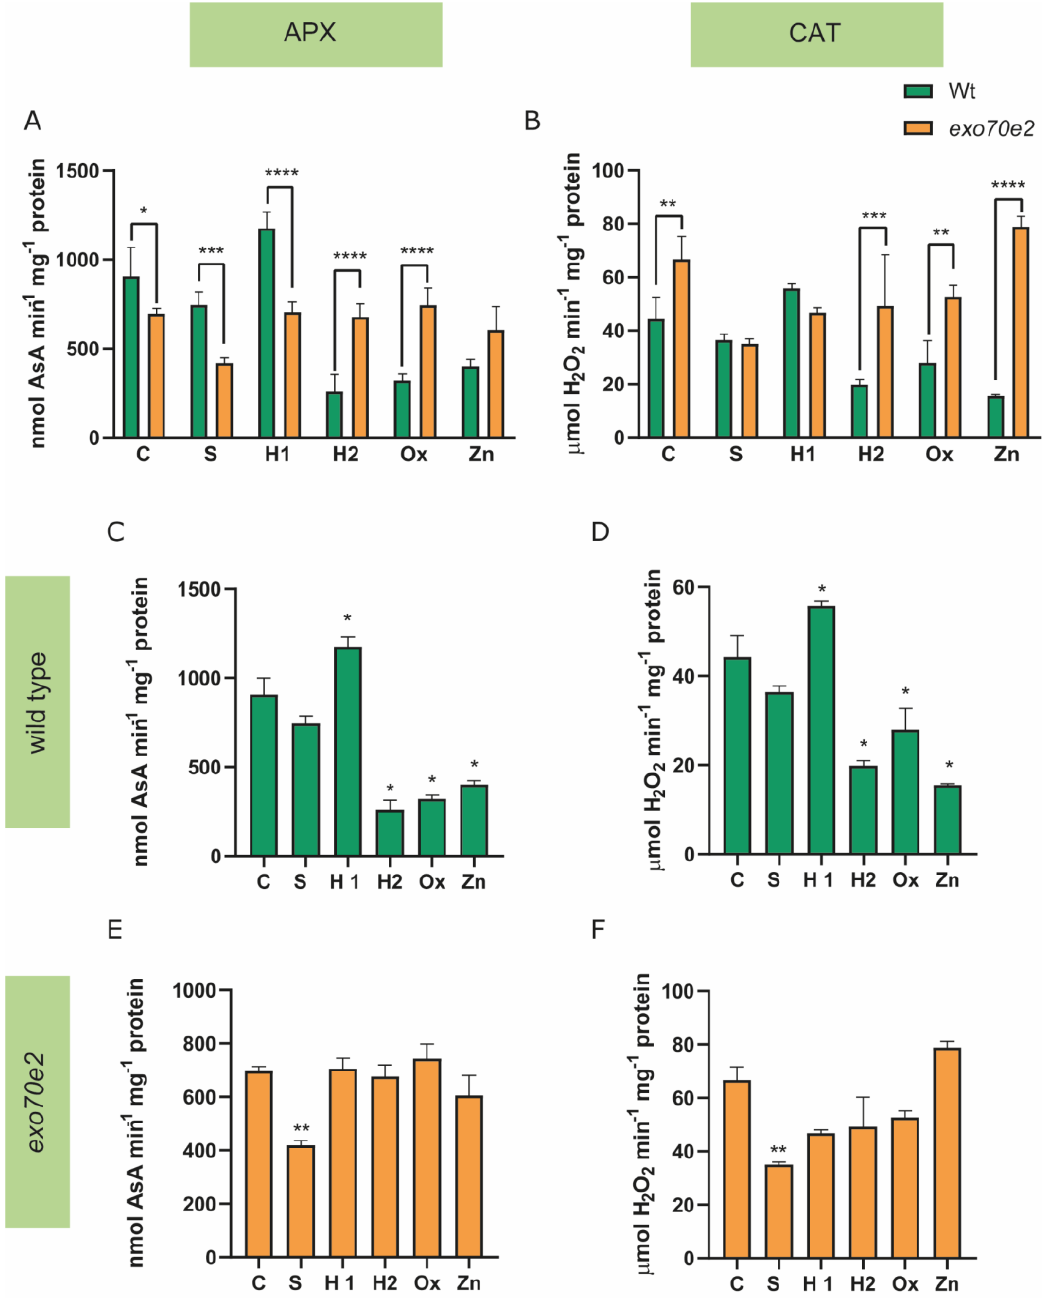
Figure 6. APX and CAT activity in exo70e2 plants in control and under stress. ( A , B ) Comparison of APX and CAT activity, respectively, in wt and exo70e2 plants. ( C , E ) APX activity calculated for wt and exo70e2 plants grown under stress. ( D , F ) CAT activity calculated for wt and exo70e2 plants grown under stress. Results are presented as mean ± standard deviation (SD) from the evaluation of at least three experimental replicates (n ≥ 3). No alterations in CAT and APX activity in control conditions between wt and exo70e2 plants were observed. APX and CAT activity was significantly reduced in wt plants under H2, Ox, and Zn conditions, while for the mutant background, no changes are observed. * ( p value ≤ 0.05); ** ( p value ≤ 0.01); ***( p value ≤ 0.001); **** ( p value < 0.0001), according to the one-way ANOVA statistical tests. C — control; S — salt stress (50 mM NaCl); H1 — drought stress (50 mM mannitol); H2 — drought stress (10 mM mannitol); Ox — oxidative stress (0.5 mM hydrogen peroxide); Zn — metal poisoning stress (150 µM zinc sulphate).